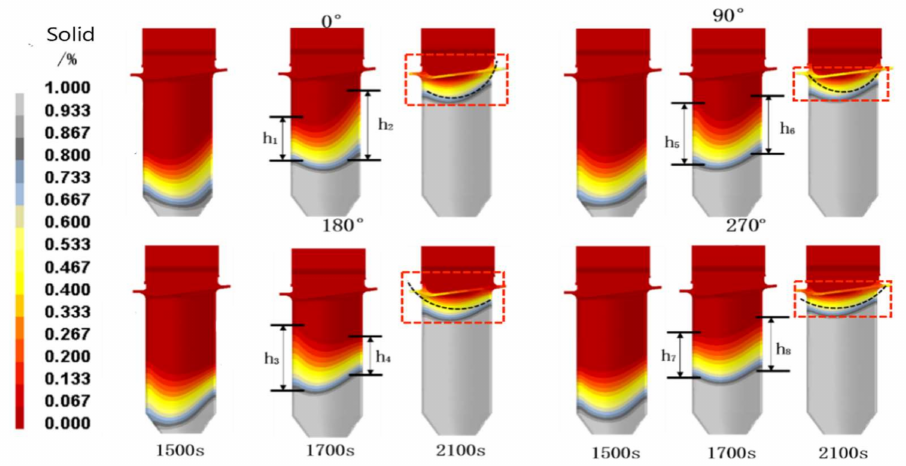
Figure 13. Mushy zone shape at different assembly